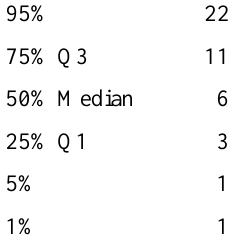
Table 6: Distribution of 2003 prescriptions by anatomical main group of CSS enrollees who had any 2003 cardiovascular drug prescriptions WHO ATC anatomical main group